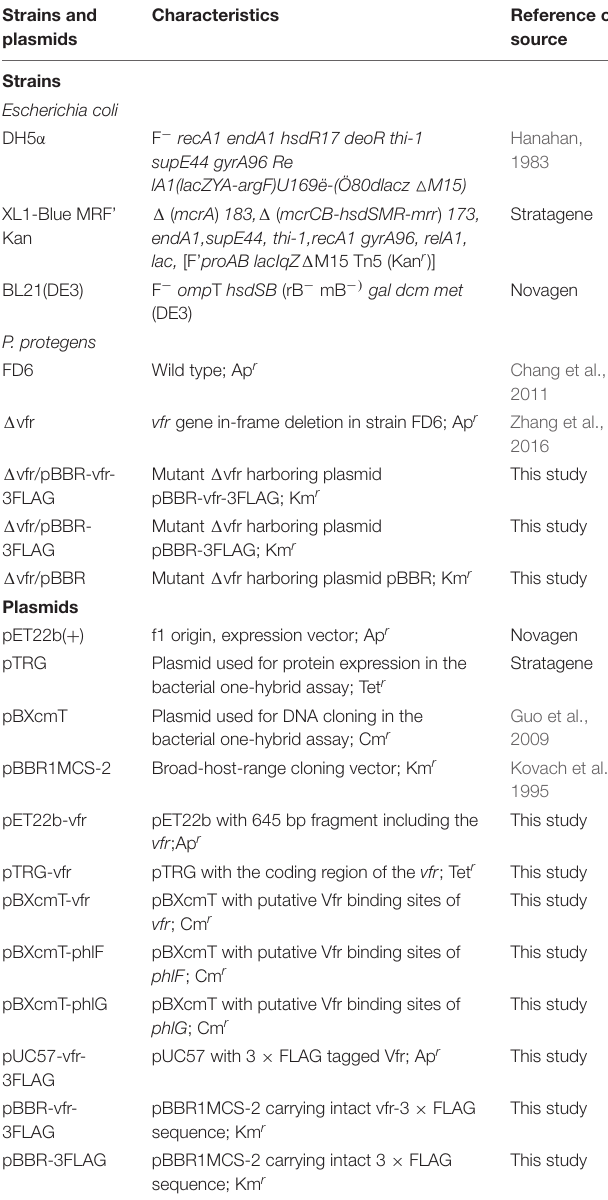
TABLE 1 | Bacterial strains and plasmids used in this